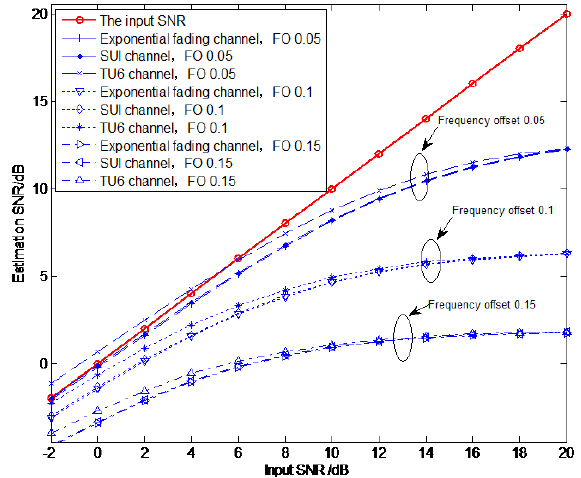
Figure 6. Estimation performance with different frequency offsets.